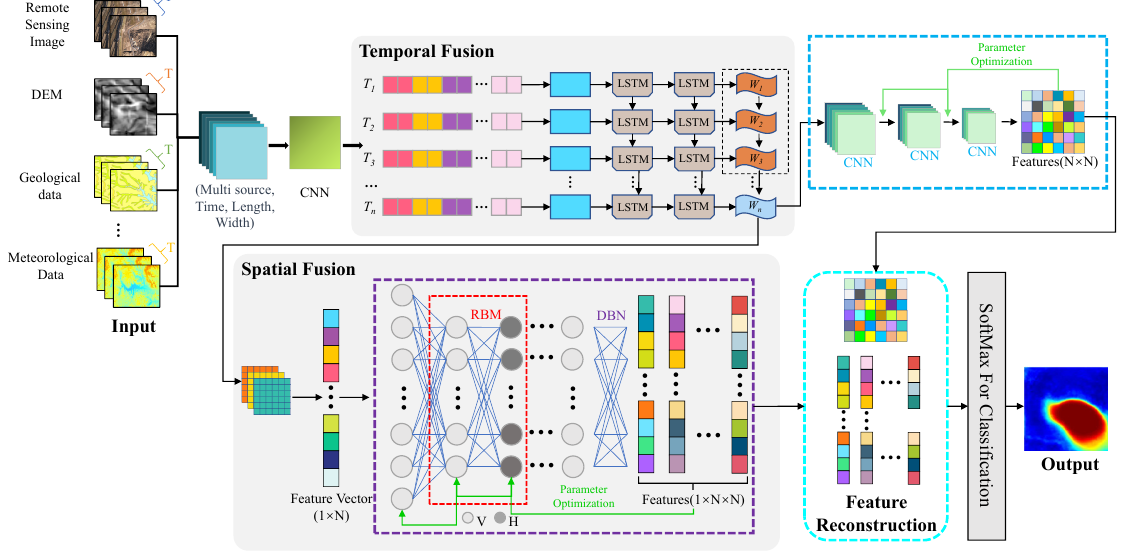
Figure 1. Overview of the proposed method. The network has three components: 1. The CNN performs feature extraction on the 3D convolutional pair (multi-source, temporal, long, and wide) data, and the extracted temporal-spatial features are selectively compressed by the LSTM to achieve data fusion in the temporal dimension, and then the single-dimensional landslide features are restored to their original data dimensions by the upsampling network. 2. The DCNN-DBN network expands all the shallow features of each class of image elements into a one-dimensional vector as the input variables of the DBN. The fused feature data and the original data are used as the input of the DCNN network. 3. After the information extraction of the input data through DBN and DCNN networks respectively, the output feature vectors of both are feature reconstructed and merged into a feature matrix and input to a logistic regression classifier for discrimination, and then landslide identification is